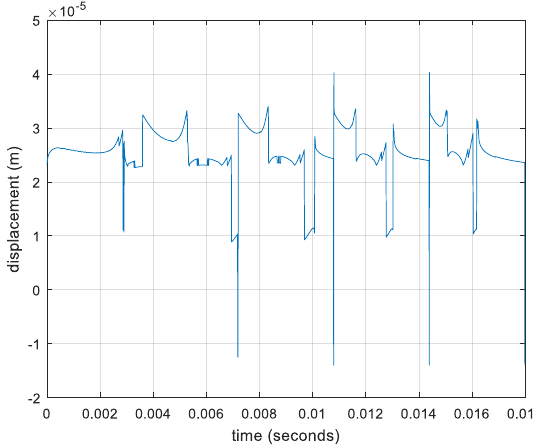
Figure 16. Vibration in time domain (machine with demagnetization fault).